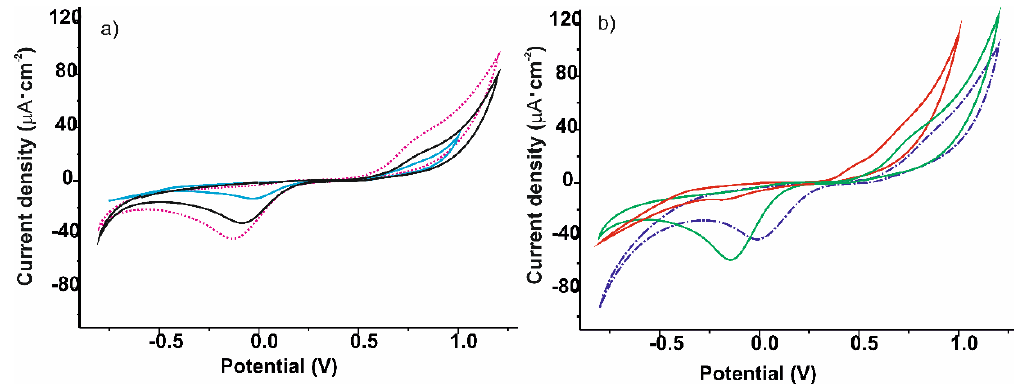
Figure 4. Cyclic voltammograms registered in catechol 10 −3 mol∙L −1 (0.01 M phosphate buffer as electrolyte using ( a ) AuNP tOcBr (blue —), ZnPc RS (pink ······ ), ZnPc R -S-ZnPc R (black —) and of ( b ) the mixture AuNP tOcBr /ZnPc RS (purple ∙–∙–∙), the mixture AuNP tOcBr /ZnPc R -S-ZnPc R (green — ) and the covalent adduct AuNP tOcBr -S-ZnPc R (red —), Scan rate 100 mV∙s −1 .